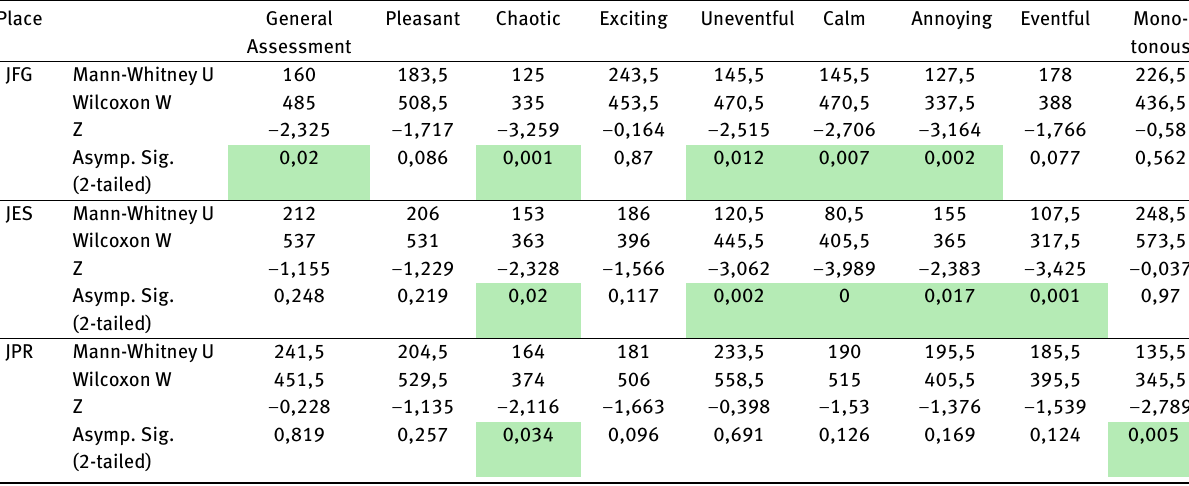
Table 4: Non-parametric Mann-Whitney tests.